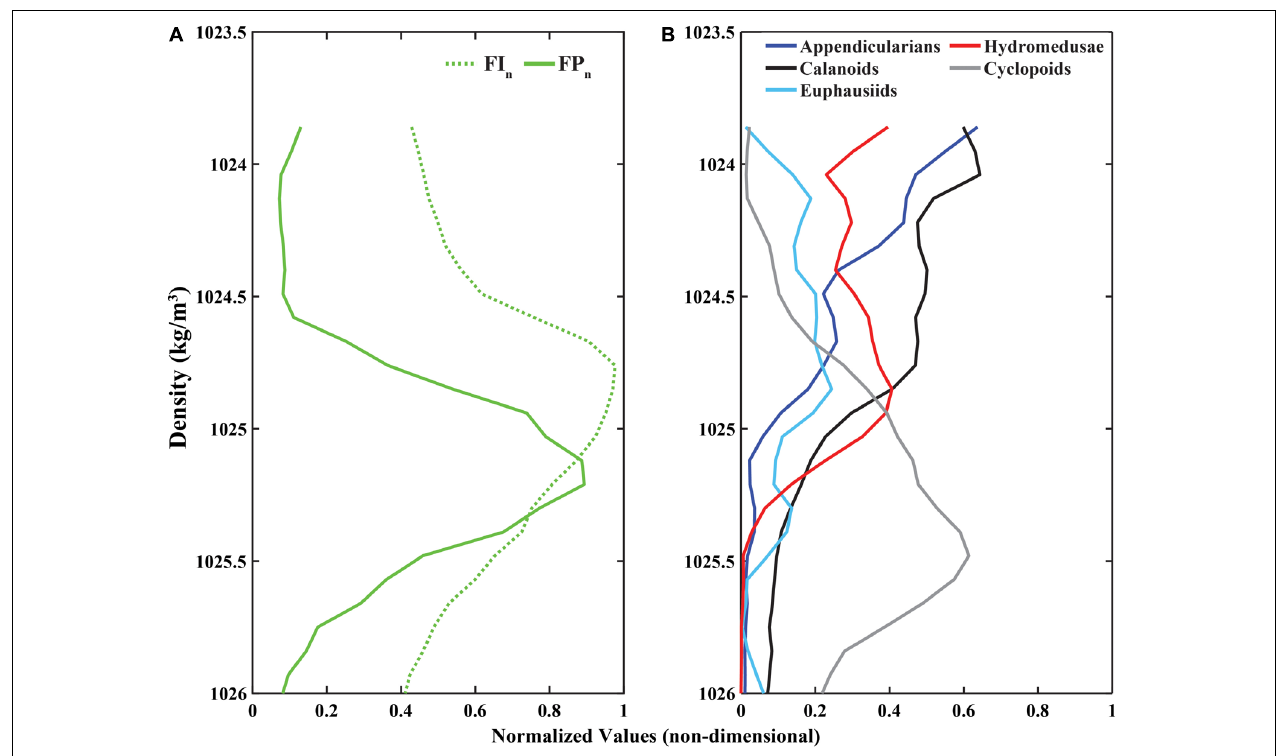
FIGURE 7 | Canonical profiles (time-averaged normalized values in density coordinates) for (A) Fluorescence Intensity (FI n ; green dotted line) and Fluorescent Particles (FP n ; green solid line), and (B) appendicularians, calanoid copepods, cyclopoid copepods, euphausiids, and hydromedusae.